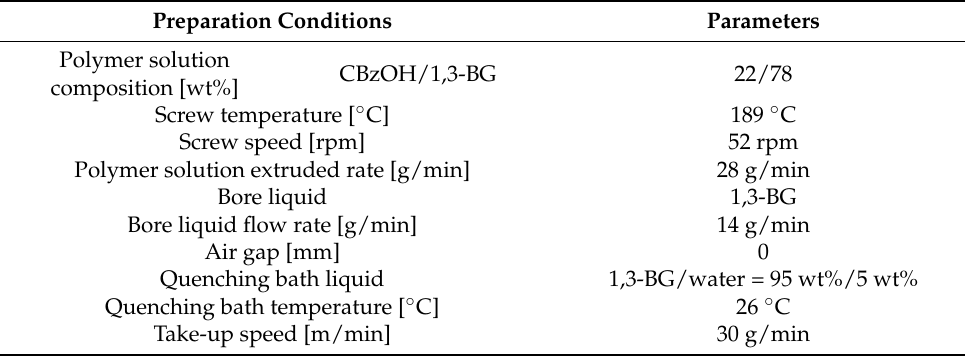
Table 2. Preparation Conditions of CBzOH Hollow Fiber Membranes via TIPS method.